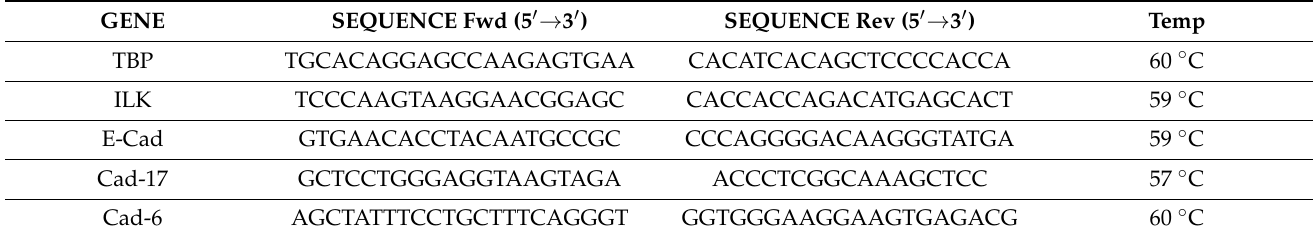
Table 2. Primer sequences used in RT-qPCR and temperature